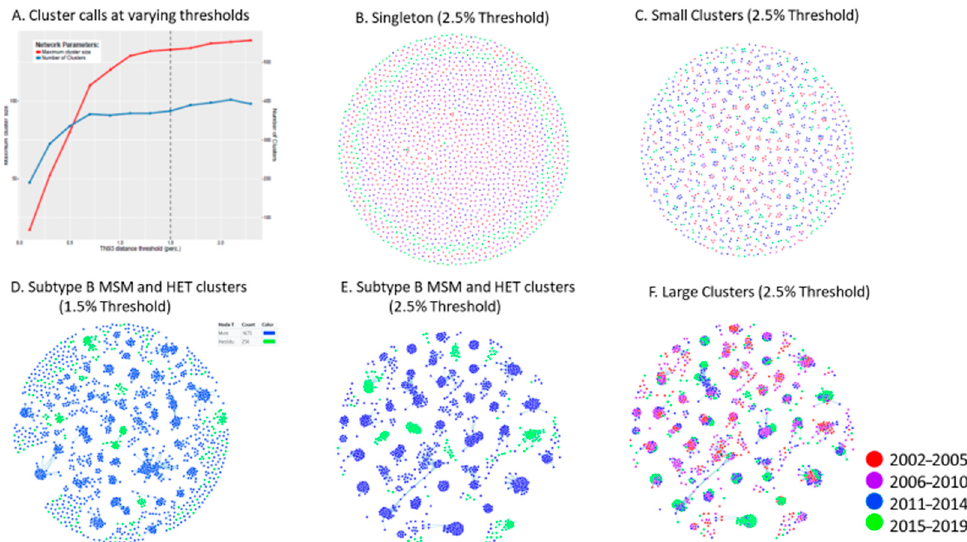
Figure 5. Phylogenetic resolution of patterns of HIV spread using HIV-TRACE and Microbe TRACE compared to MEGA10 phylogeny. ( A ) The number and size of individual clusters assigned by HIV-TRACE at different genetic distances (GDs). ( B ) MicrobeTrace topology (2.5% GD) of singleton transmissions assigned based on MEGA10 phylogeny. 5 ( C ) MicrobeTrace topology (2.5% GD) of small clusters assigned using MEGA10. ( D , E ) MicrobeTrace (1.5% and 2.5% GD) shows single- ton/small cluster outliers at 1.5% failing to associate with MEGA10-defined large clusters. ( F ) MicrobeTrace (2.5% GD) depicts years of infection of large cluster members.